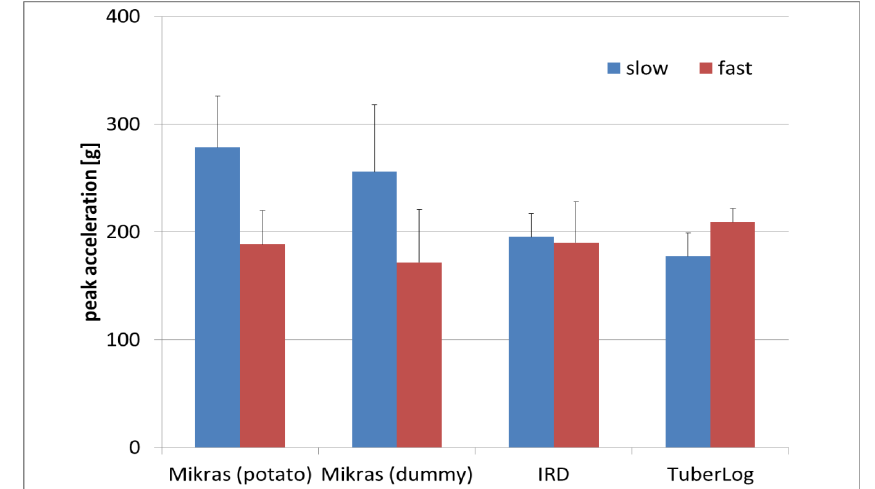
Figure 12. Mean values of peak acceleration at the highest falling step (34 cm) of the processing line simulator without chute with slow and fast conveyor speed (0.19 m·s −1 and 0.35 m·s −1